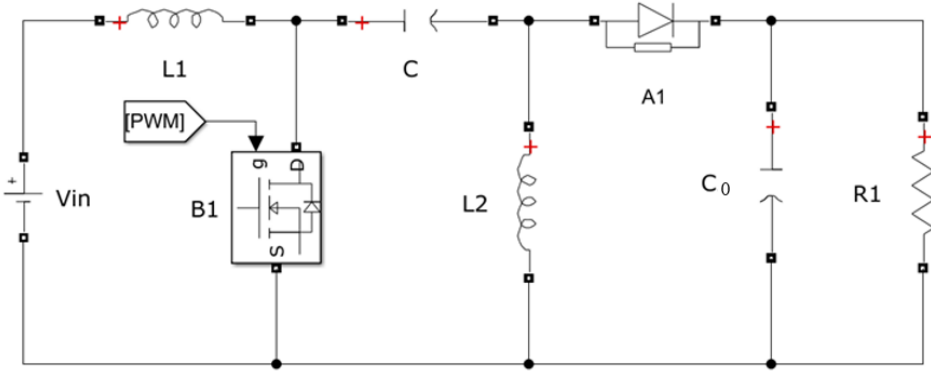
Figure 17. Simulink/Simscape model of the SEPIC converter.